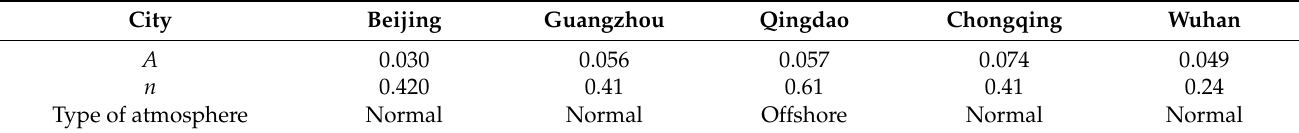
Table 1. Statistical values of A and n in representative regions of